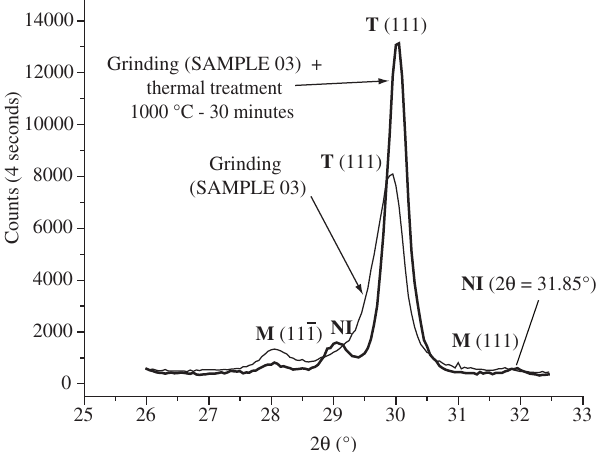
Figure 5. X ray diffractions of a single ZTA sample at two moments: after grinding and after a heat treatment. NI= non-identified peak.